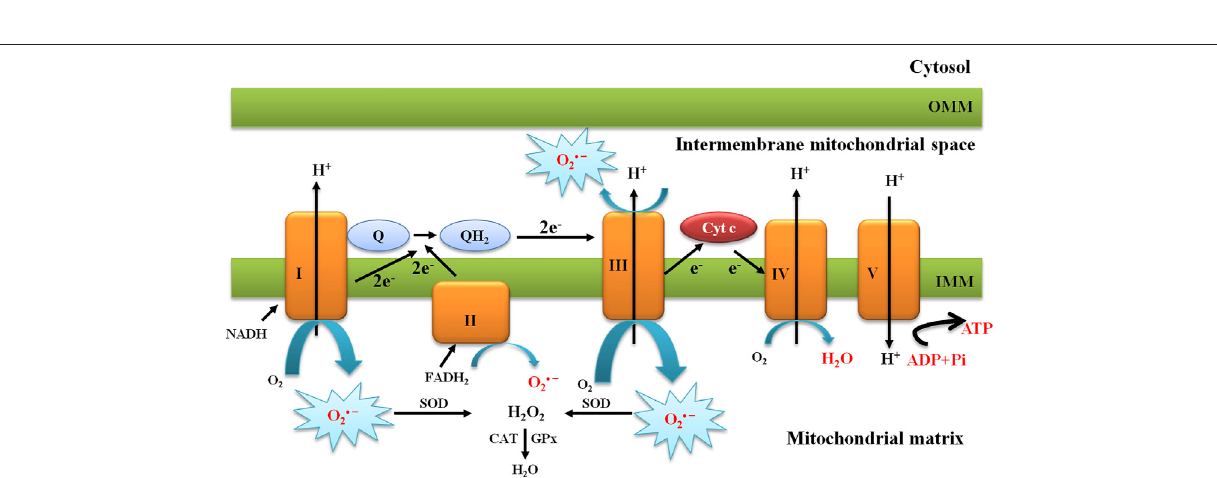
FIGURE2| SchematicpresentationofthemitochondrialelectrontransportchainandproductionofmitochondrialO 2 (cid:129) − .Themitochondrialelectrontransportchain produces ROS. Mitochondrial complexes I and II use electrons donated from NADH and FADH 2 to reduce coenzyme Q. Coenzyme Q shuttles these electrons to complex III,where they are transferred to cytochrome c.Complex IV uses electrons from cytochrome c toreduce molecular oxygen to water. The action of complexes I, III, and IV produce a proton electrochemical potential gradient, the free energy of which is used to phosphorylate ADP at ATP synthase. Complexes I, II, and III produce superoxide through the incomplete reduction of oxygen to superoxide, whereas complexes I and II produce superoxide only into the mitochondrial matrix and complex III produces superoxide into both the matrix and the intermembrane